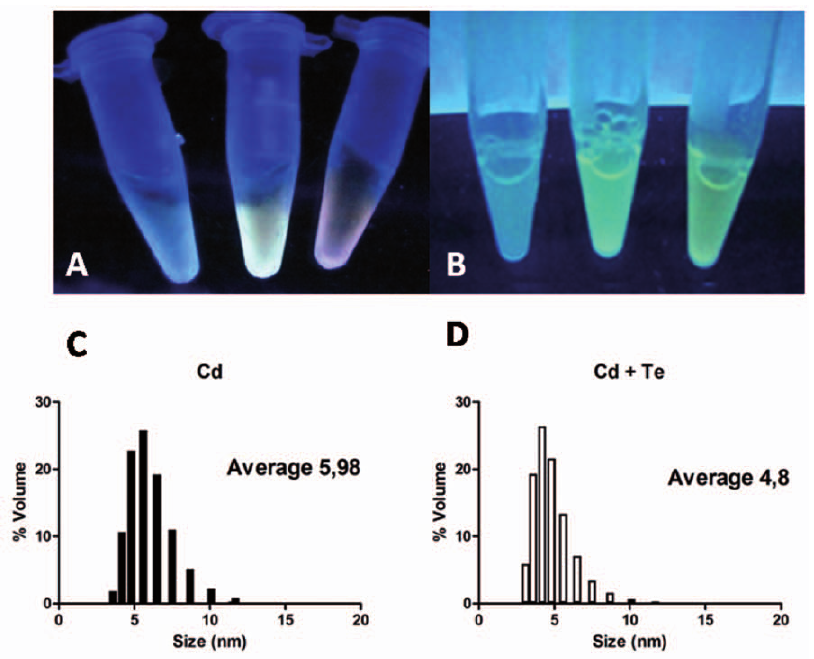
Figure 4. Particle purification and size determination. A, UV-exposed cell suspensions of E. coli AG1/pCA24N gshA , untreated or exposed to CdCl 2 or CdCl 2 /K 2 TeO 3 (from left to right). B, purified fractions exposed to UV light. C and D , DLS particle size determination of fluorescent samples from cells exposed to CdCl 2 or CdCl 2 /K 2 TeO 3 , respectively.